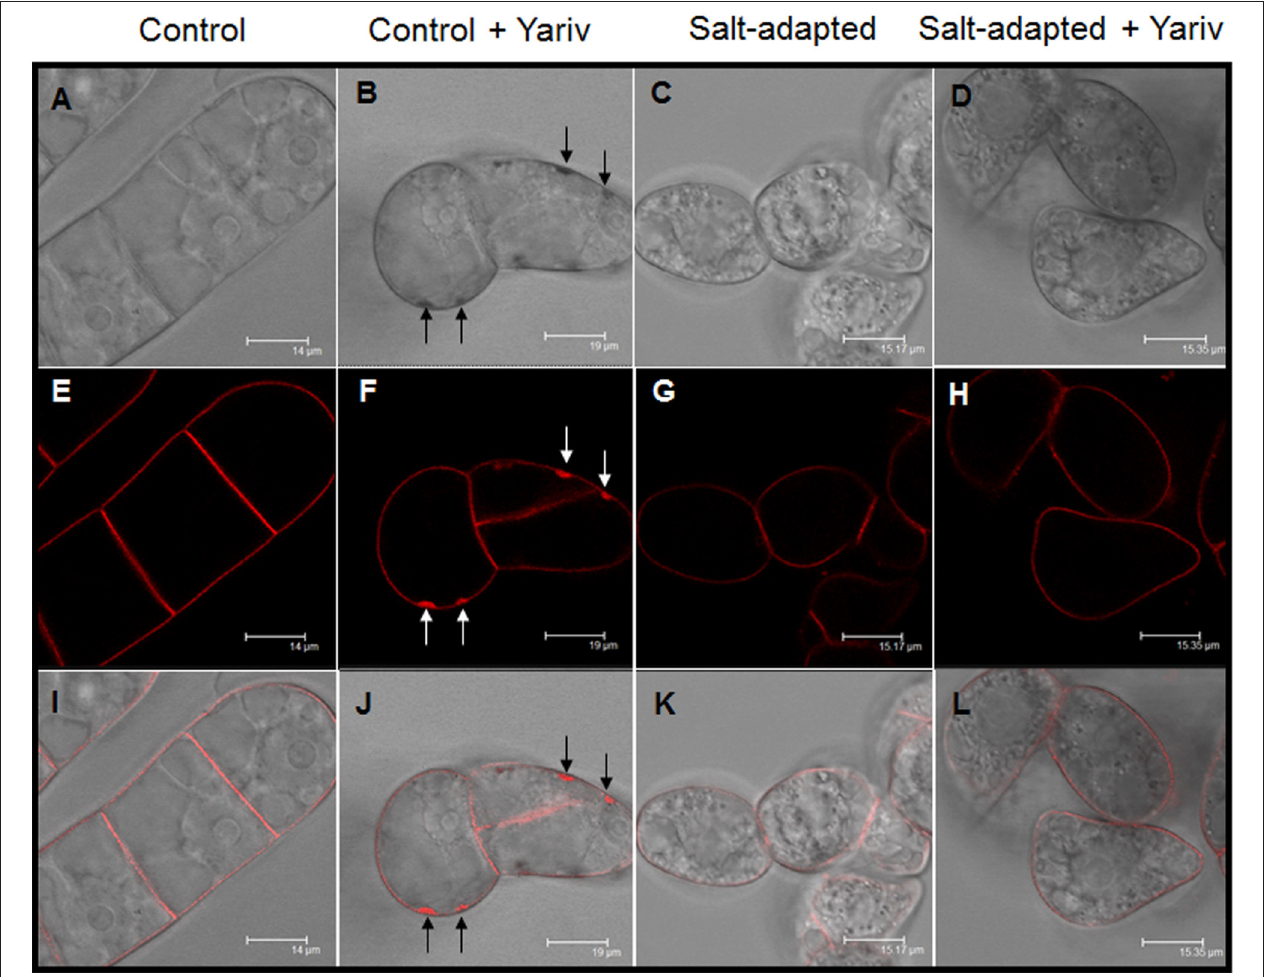
FIGURE 5 | Cellular localization by fluorescence microscopy of Yariv precipitates on samples of control (A,B,E,F,I,J) and salt-adapted (C,D,G,H,K,L) tobacco BY-2 cells treated and non-treated with 100 µ M Yariv reagent for 24 h. (A – D) DIC images; (E–H) FM4-64 fluorescence images; (I–L) Overlapping of DIC and fluorescence images. Arrows in (B,F,J) indicate the location of the precipitates of Yariv